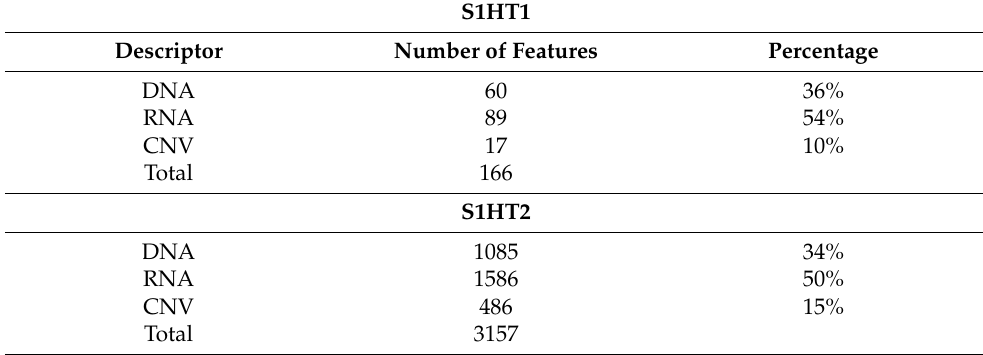
Table 11. Composition of datasets.